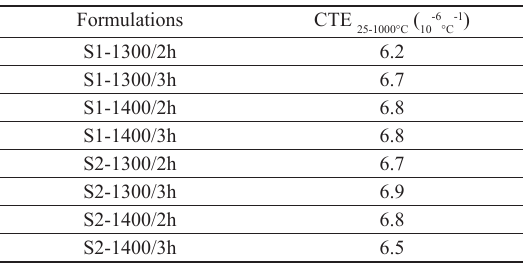
Table 5. Thermal expansion coefficients (TEC) of formulations S1 and